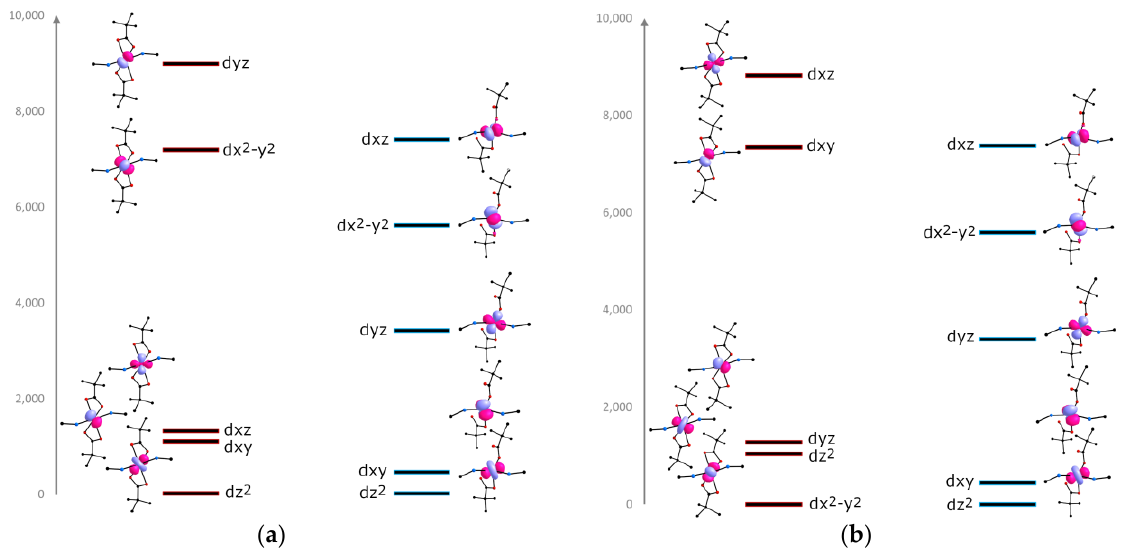
Figure 6. CASSCF/NEVPT2-calculated relative energies of a d-orbitals for α - 1 (red states) and γ - 1 (blue states). Change in the splitting of orbitals for Co1 2+ ion ( a ), and for Co2 2+ ( b ).